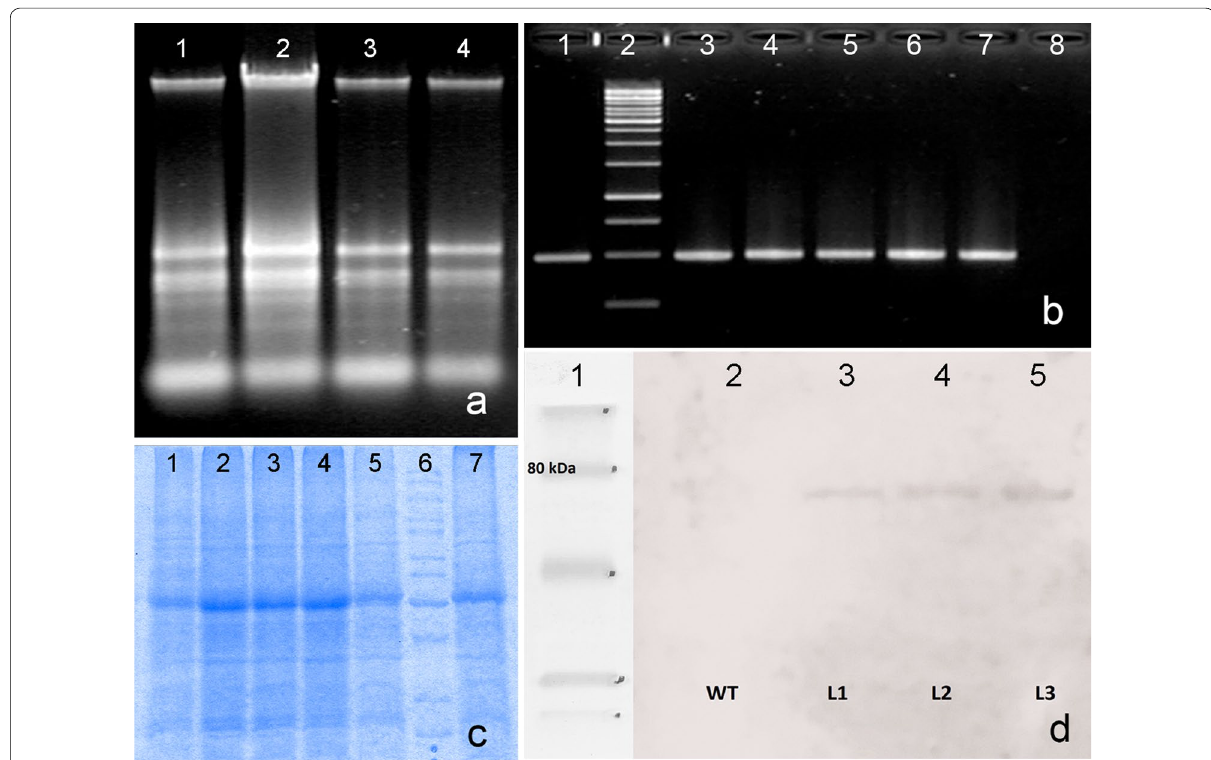
Fig. 2 Molecular analysis of transformants. a Electrophoresis of genomic DNA: lane 1 —a wild type plant (WT), lanes 2–4 —independent transgenic lines (TL1, TL2, TL3); b detection of the coding sequence of the gusPlus gene (488 bp) in B. oleracea var. botrytis transgenic and wild‑type plants. Lane 1 —a positive control (PC, plasmid 1305.2), lane 2 —a molecular weight marker (GeneRuler 1 kb DNA Ladder), lanes 3–7 —independent transgenic lines (TL1, TL2, TL3, TL4, TL5), lane 8 —a wild‑type plant (WT); c SDS‑PAGE separation of proteins from the transgenic cauliflower plants. Lane 1 – 5 — independent transgenic lines (TL1, TL2, TL3, TL4, TL5), lane 6 —molecular weight marker (M—GPB 260 kDa Protein Marker), lane 7 —a wild type plant (WT); d detection of the β ‑glucuronidase protein in the total extractable protein isolates derived both from B. oleracea var. botrytis wild type and transgenic plants. Lane 1 —molecular weight marker (M—GPB 260 kDa Protein Marker), lane 2 —a wild type plant protein isolate (WT), lanes 3,4 —independent transgenic lines (L1, L2), lane 5 —positive control (L3). Contrary to the wild type, in the case of transgenic plant extracts a positive signal was observed (about 80